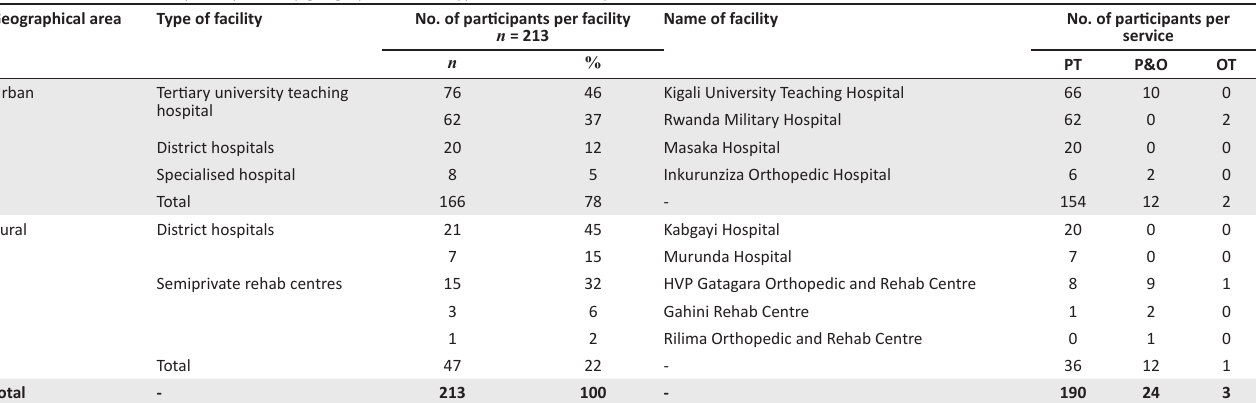
TABLE 2b: Distribution of participants, by geographical area, type of health facility visited and rehabilitation services received. Geographical